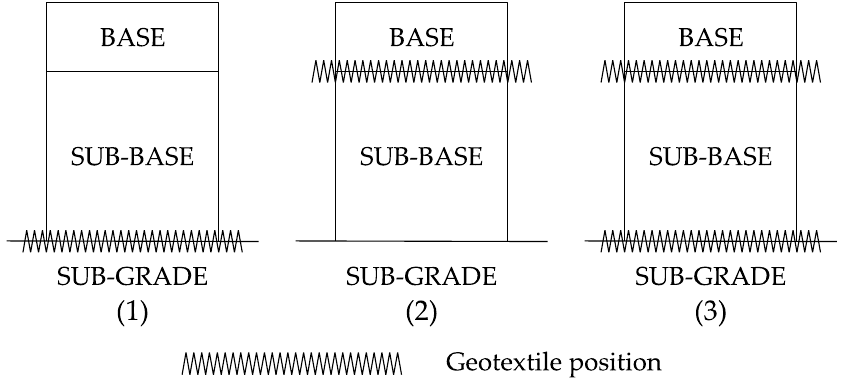
Figure 1. Pervious pavement configurations.